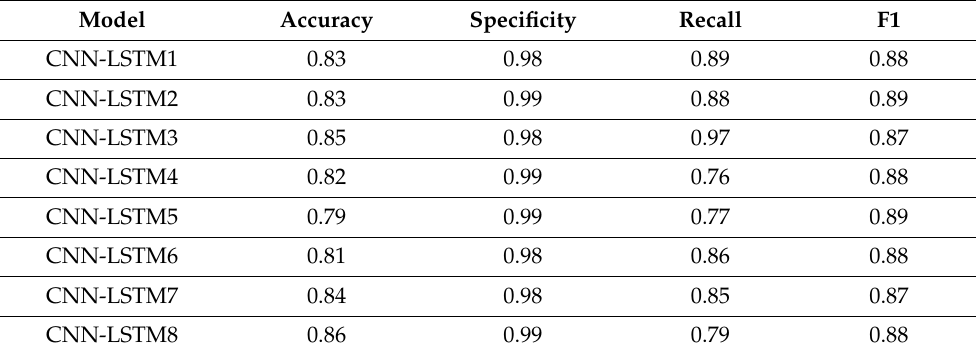
Table 2. Model performance metrics of CNN-LSTM.